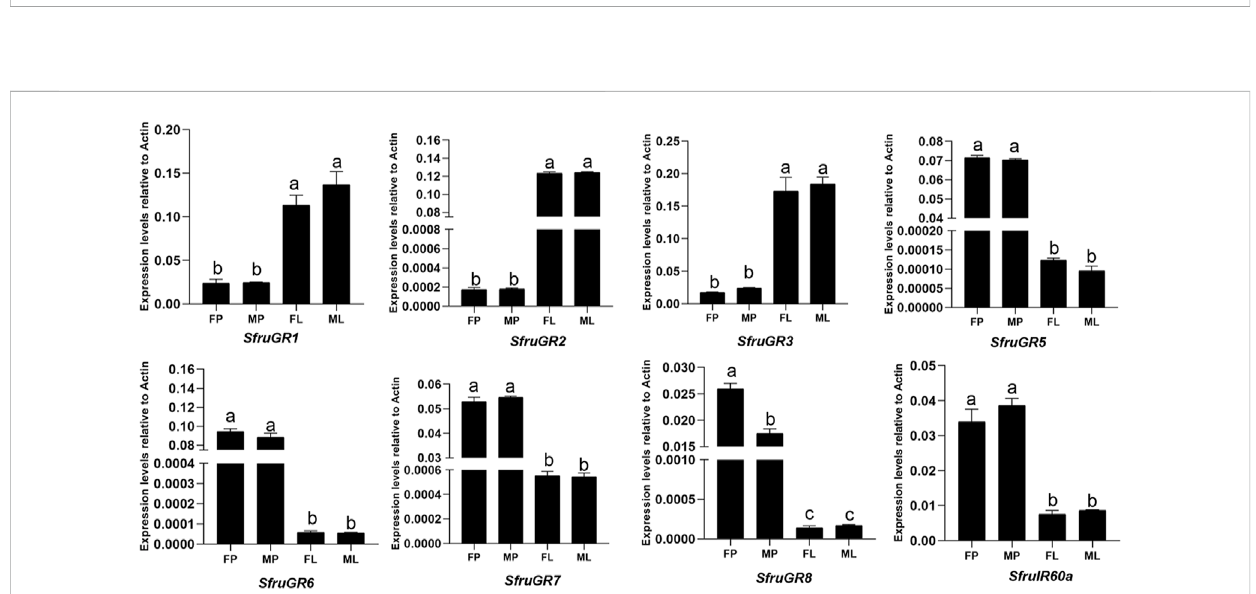
FIGURE 8 Comparison of the genes displaying high expression in the mouthpart among female proboscises (FP), male proboscises (MP), female labial palps (FL), andmalelabial palps (ML). Different letters indicate signi fi cant difference based on aone-way ANOVA followed byTukey ’ smultiplecomparison test. Error bars show the standard errors of the means (+SE), p < 0.05, n =